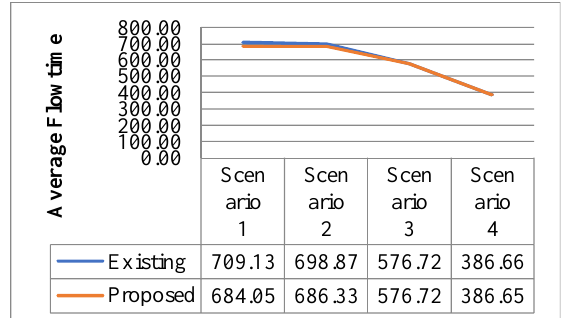
Figure 4. Comparison of existing & proposed